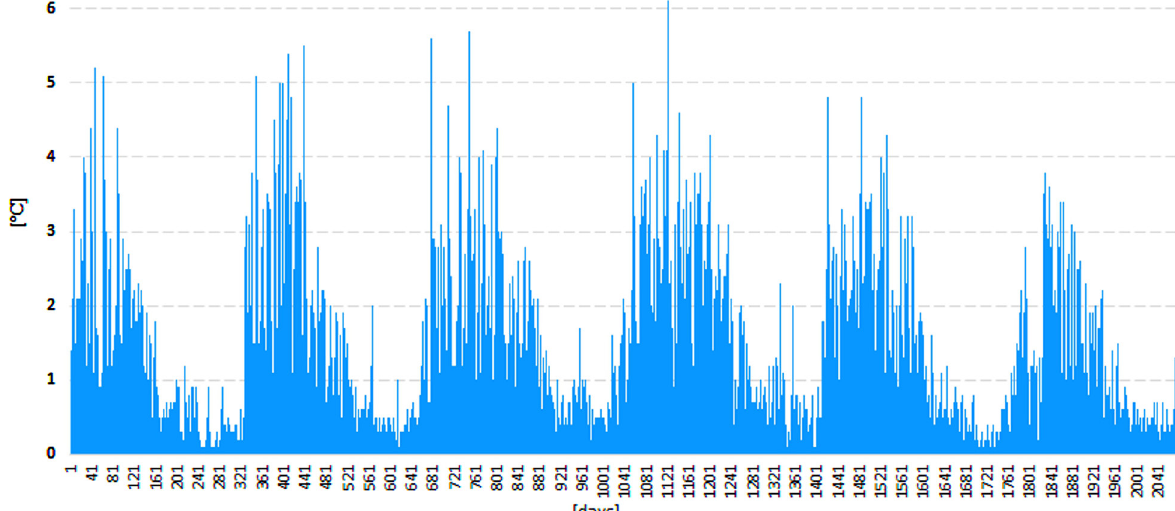
Fig. 4. Daily water temperature fluctuations in Lake Kierskie (May 2012–january